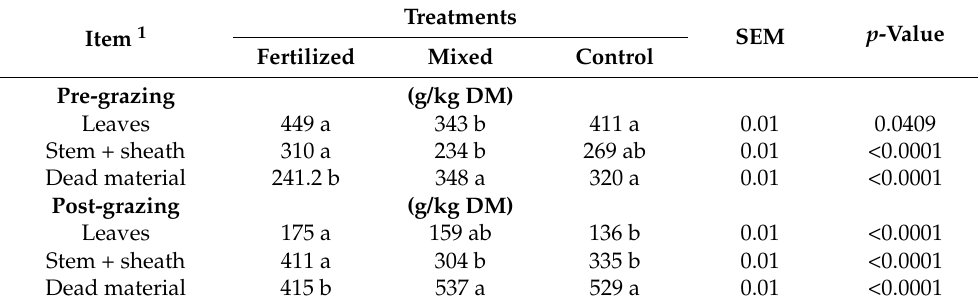
Table 5. Morphological composition and herbage disappearance rate of palisade grass fertilized with urea (150 kg N/ha/year), mixed with pintoi peanut (mixed), and without N fertilization (control). Average of 2 years of evaluation of 5 grazing cycles ( n =